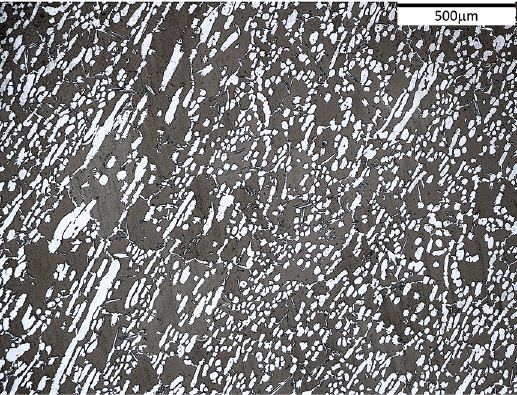
Figure 1. Micrograph of initial condition of UNS S32304 steel. OM - 50x. Behara II. The white phase is austenite and the dark one ferric matrix.